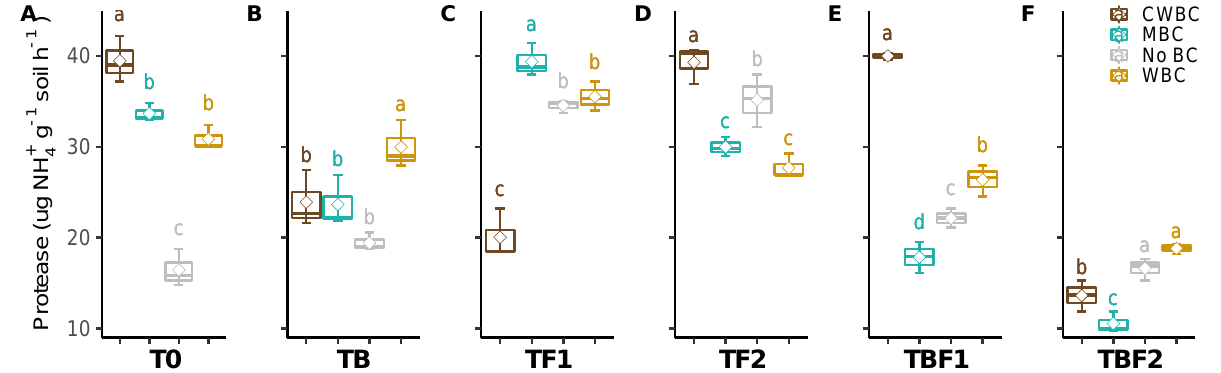
Figure 3. Effect of microbial inoculants on soil protease activity after biochar application. Treatment abbreviations — see Figure 1. Quantiles are shown at the top and bottom of the box. Max and min values are indicated by the bars. The lines within the box indicate the median values. The transparent dot indicates the observation value. Letters above the bars indicate the significance level at p < 0.05 by LSD.